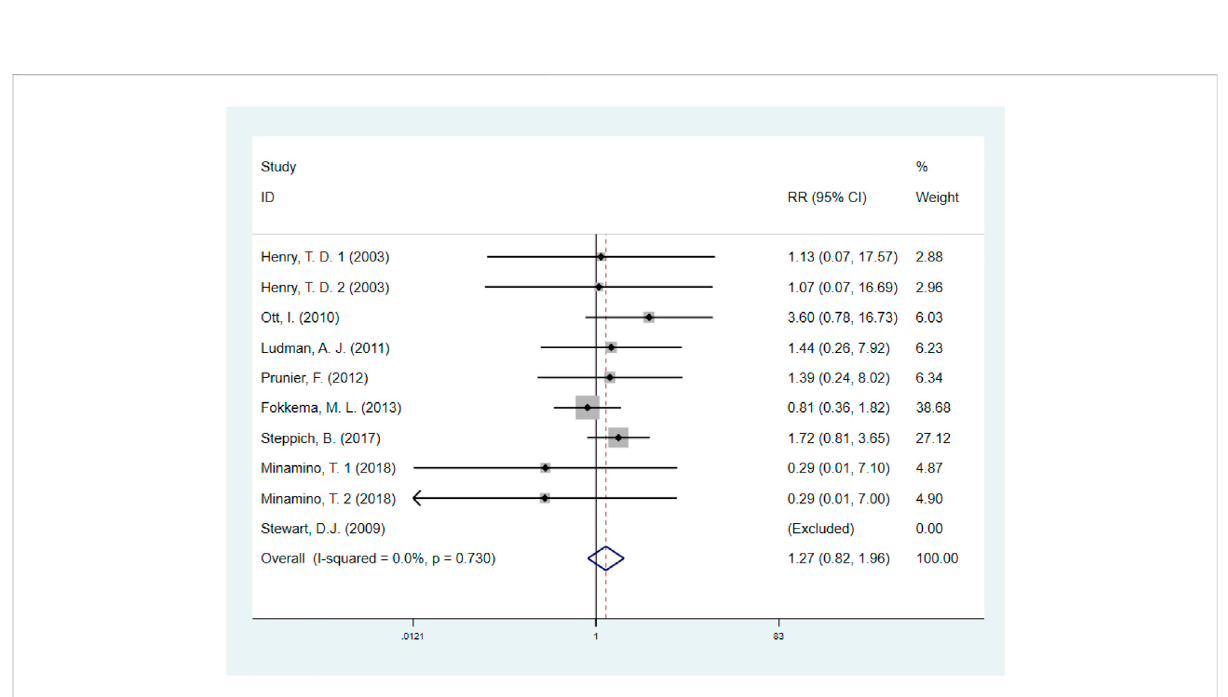
FIGURE 5 Forest plot for revascularization, GF vs. control. RR, relative risk; CI, con fi dence interval; ID, identi fi